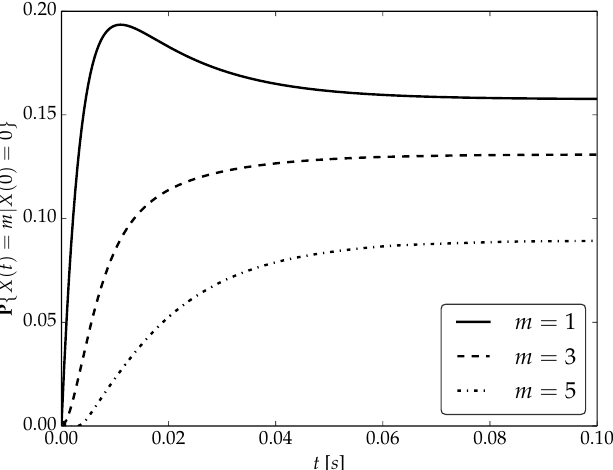
Figure 1. Transient probabilities P equal 2 ms.